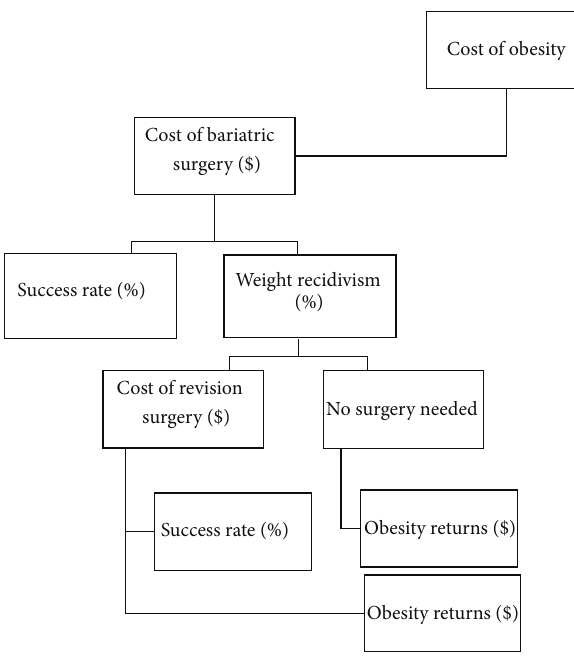
Figure 1: Process of primary bariatric surgery to revision surgery and their